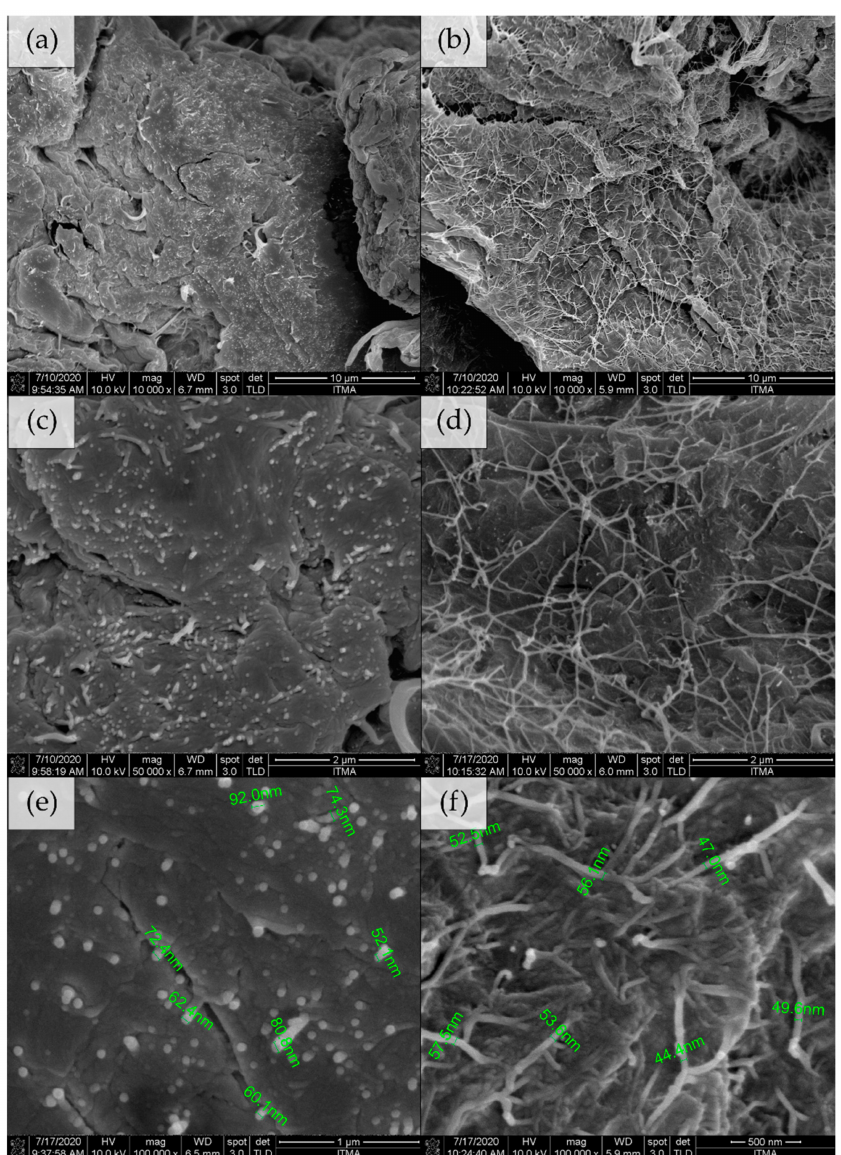
Figure 6. Fracture surface of UHMWPE/CNF prepared by ( a , c , e ) melt blending and ( b , d , f ) ethanol mixing at 10,000 × , 50,000 × and 100,000 × magnification, respectively.